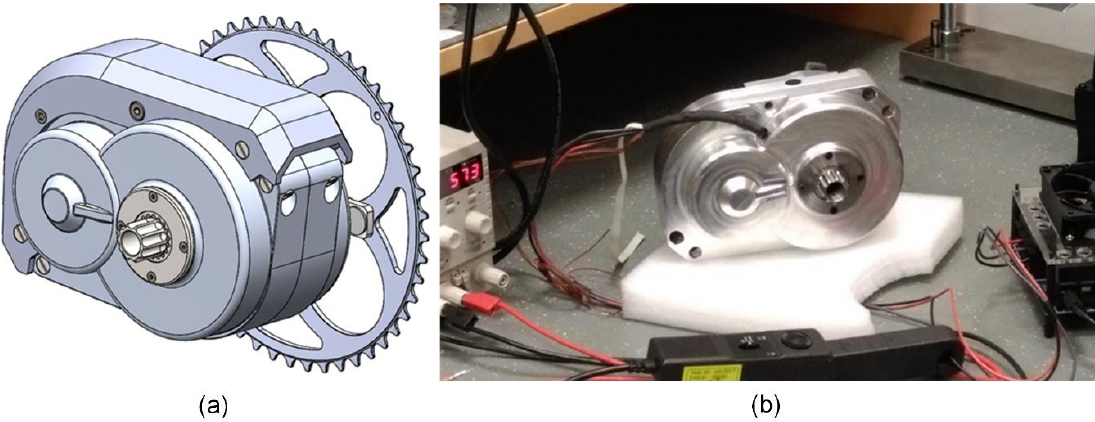
Figure 3. Prototype A1: ( a ) virtual prototype—CAD model; ( b ) functional testing of the A1 prototype with external electronics under no external load.